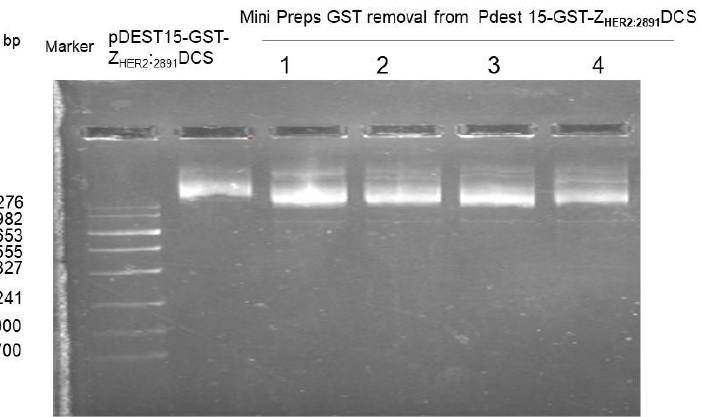
Figure 1. Isolation of DNA plasmid. An agarose gel electrophoresis was used to analyze the four reaction products (1 – 4) compared to the plasmid with GST.